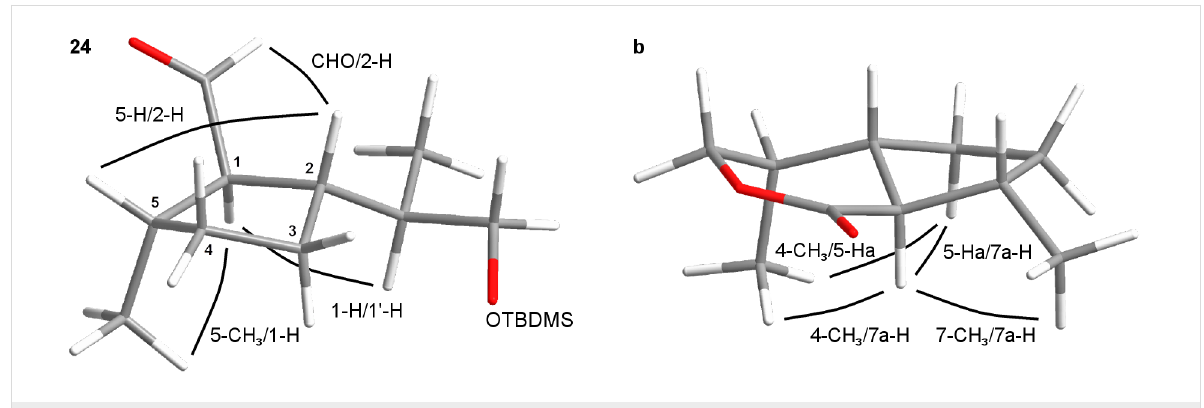
Figure 6: Configurations of compound 24 and the dihydronepetalactone b .